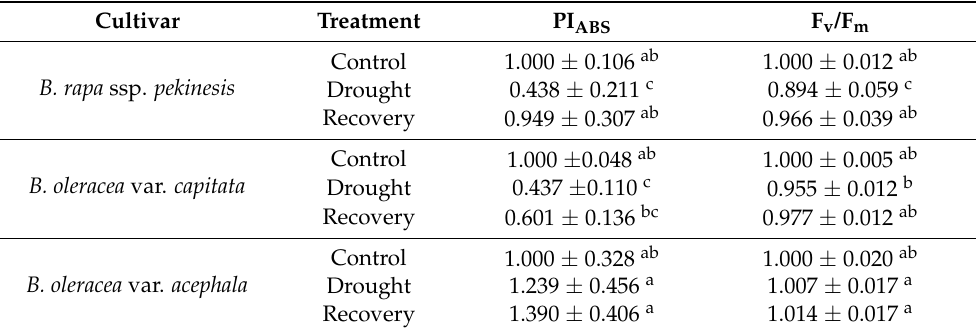
Table 1. The photochemical parameters measured in Brassica crops upon drought and recovery: the performance index (PI ABS ) and maximum quantum yield of PS II (F v /F m ). Controls are normalized to the value 1. Same letters present non-significant values at p < 0.05. Data are mean ± SD, n = 7. Raw data are presented in Supplementary Table